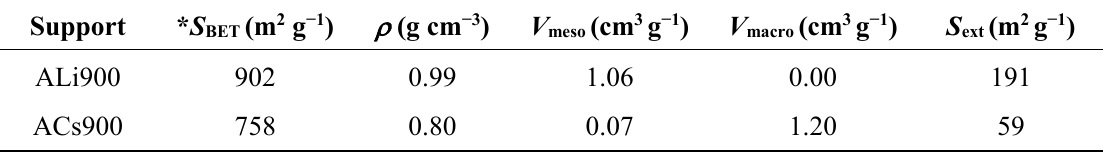
Table 2. Textural characterization of the carbon aerogels.